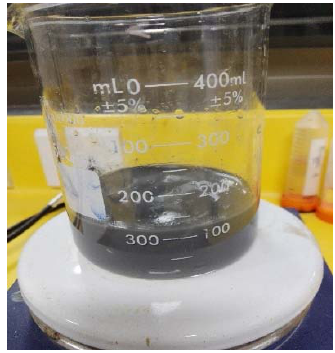
Figure 15. Catalyst slurry preparation .